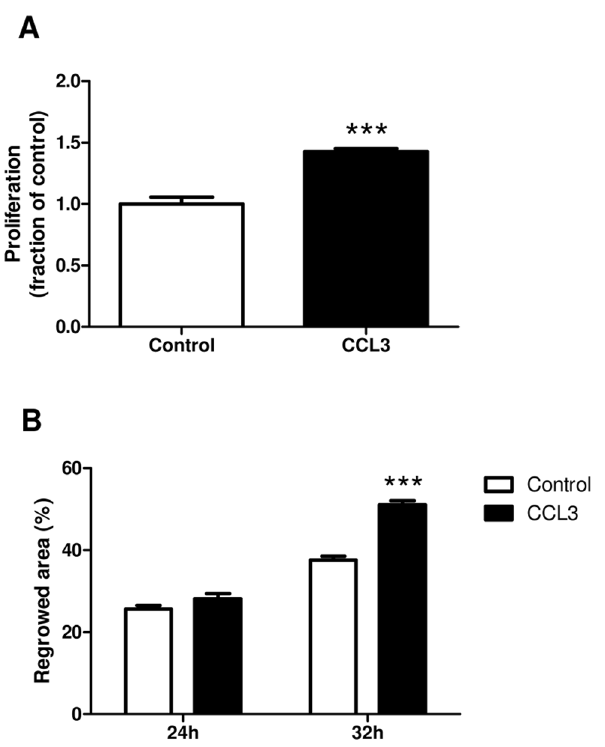
Figure 7. Invitro evidence for a role of CCL3 in liver fibrosis. Stimulation of hepatic stellate cell line (GRX) with recombinant CCL3 led to significantly increased proliferation compared to untreated cells ( A ). Stimulation of GRX cells with recombinant CCL3 showed significantly increased wound healing after 32 hours, while there is no difference after 24 hours between the groups ( B ). Data are expressed as means 6 SEM of three independent experiments. *** P , 0.001.